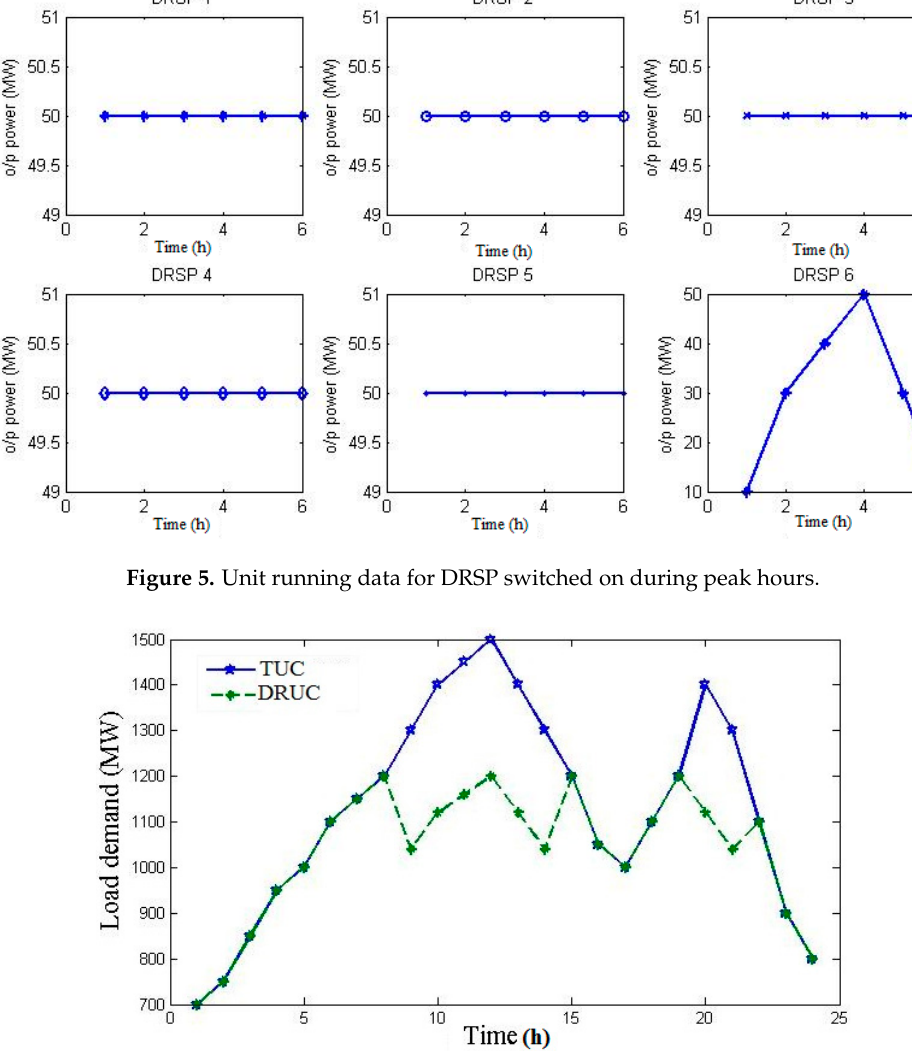
Figure 7. Profit for TUC, TUC using DR and DRUC.